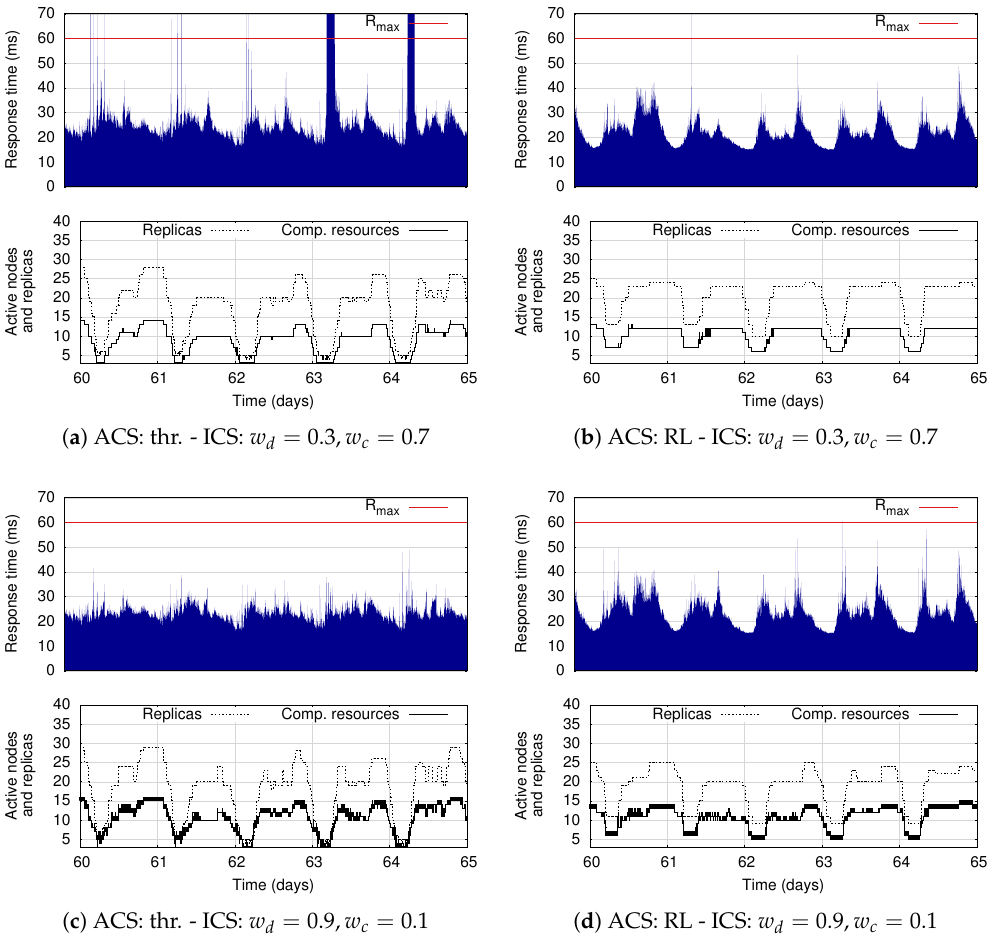
Figure 5. Application response time, number of operator replicas and active computing nodes during five simulated days at the end of the experiments, with different ACS policies (i.e., threshold-based and RL-based), and varying the cost function weights for the ICS RL-based